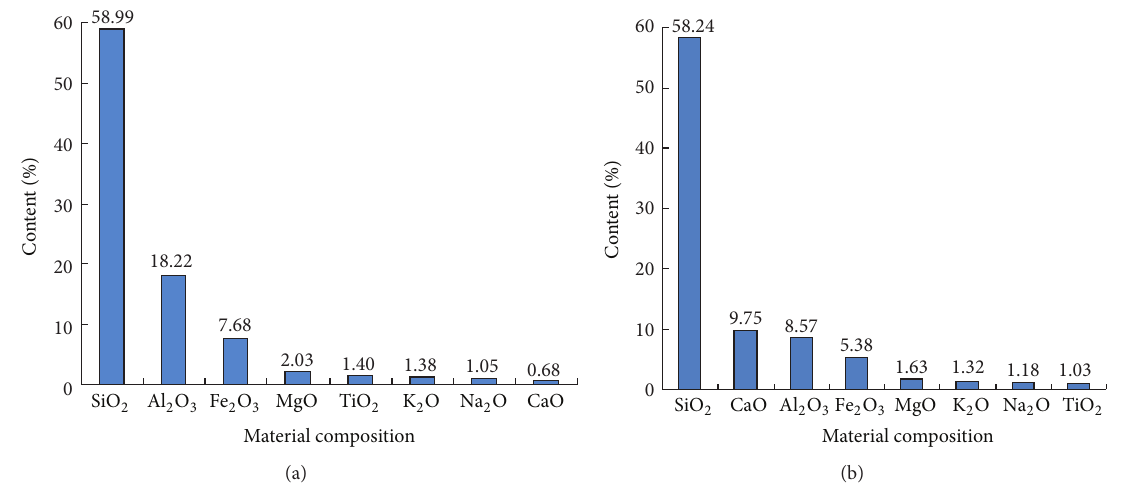
Figure 10: Material compositions of the natural Zigong argillaceous siltstone with different degree of weathering: (a) highly weathered and (b) moderately